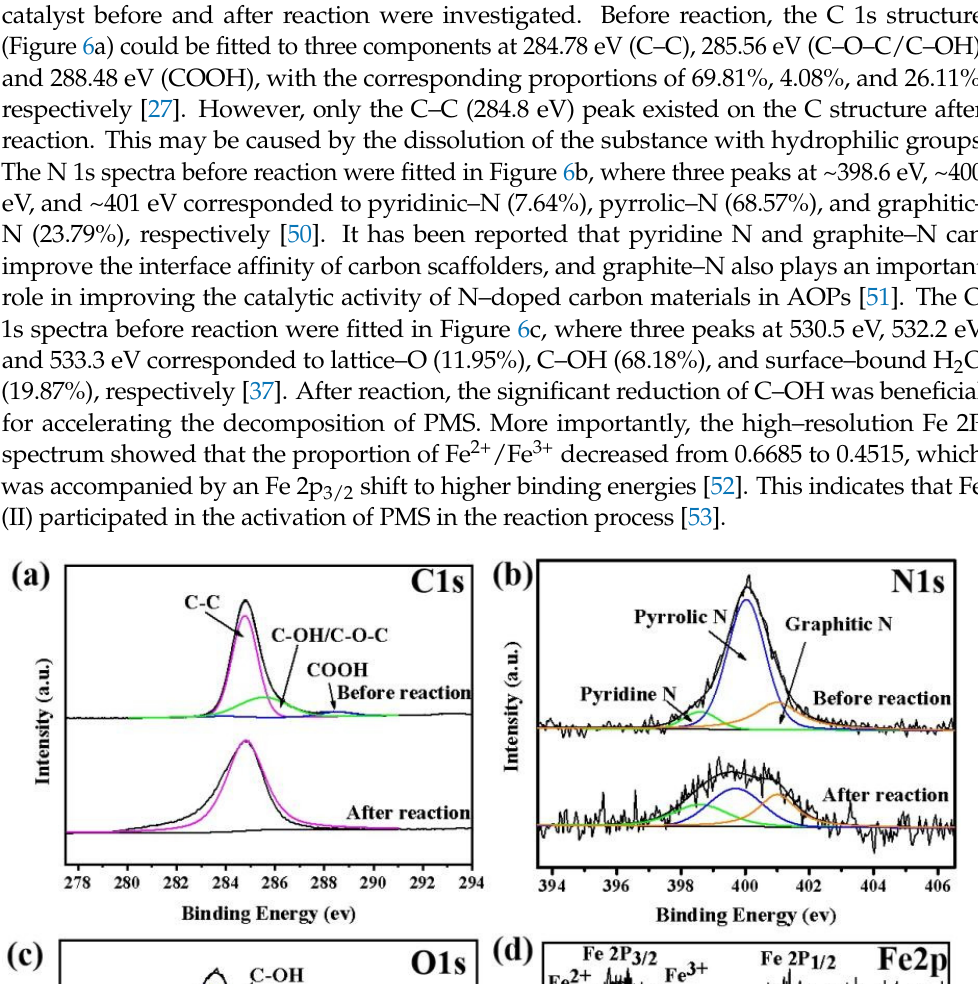
Figure 7. The possible degradation mechanisms of QNC in the E/Fe–N–BC/PMS system. 3.5. Stability and Practical Application of E/Fe–N–BC The stability of the catalyst is also crucial for its practical application. The cyclic performance of E/Fe–N–BC was evaluated according to the method shown in Text S6, and the result is described in Figure S13. The catalytic activity of E/Fe–N–BC catalysts greatly receded after the third cycle, in which the removal rate of QNC decreased from 100% to 37.14% to 17.17% for the consecutive three times it was used. According to the above, the inactive reason might be attributed to the active substance iron leaching and the oxidation of Fe (II) on the surface of catalyst. The scaled–up production of the catalyst is a critical parameter for its practical application. Mass preparation of catalysts was carried out according to the method shown in Text S4 and Figure S14. To verify the catalytic properties, four different herbicides, including dicamba (DM), atrazine (ATZ), 2,4–dichlorophenoxyacetic acid (2,4–D), and